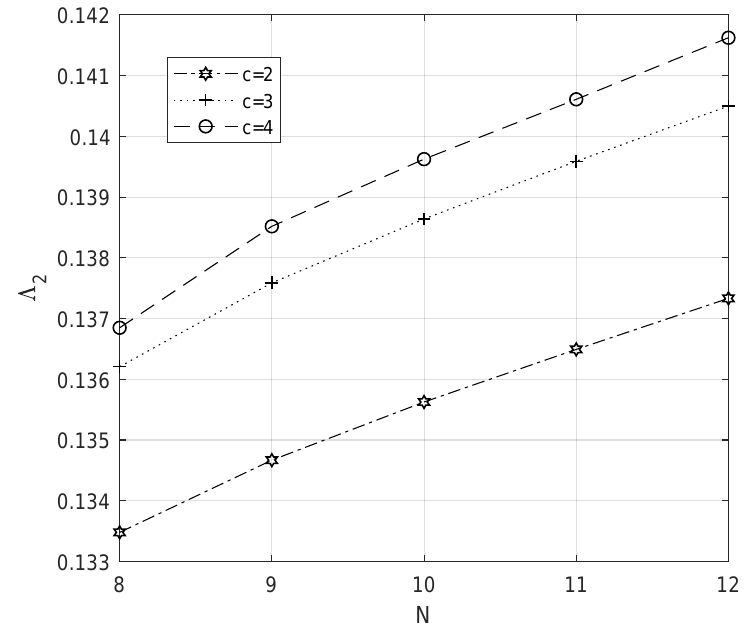
Figure 16. The impact of mean reorder rate when N vs. c